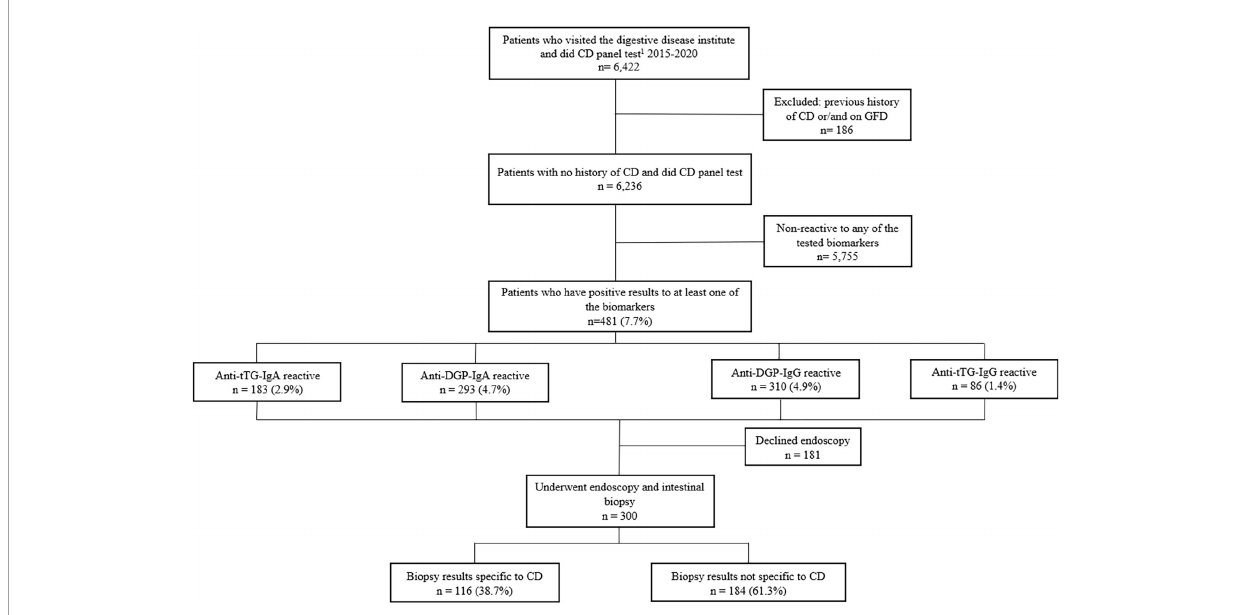
FIGURE1 Flow chart of study population screened for the four CD-serologic biomarkers and underwent endoscopy examination. 1 CD panel test includes tTG-IgA, tTG-IgG, DGP-IgA, DGP-IgG.